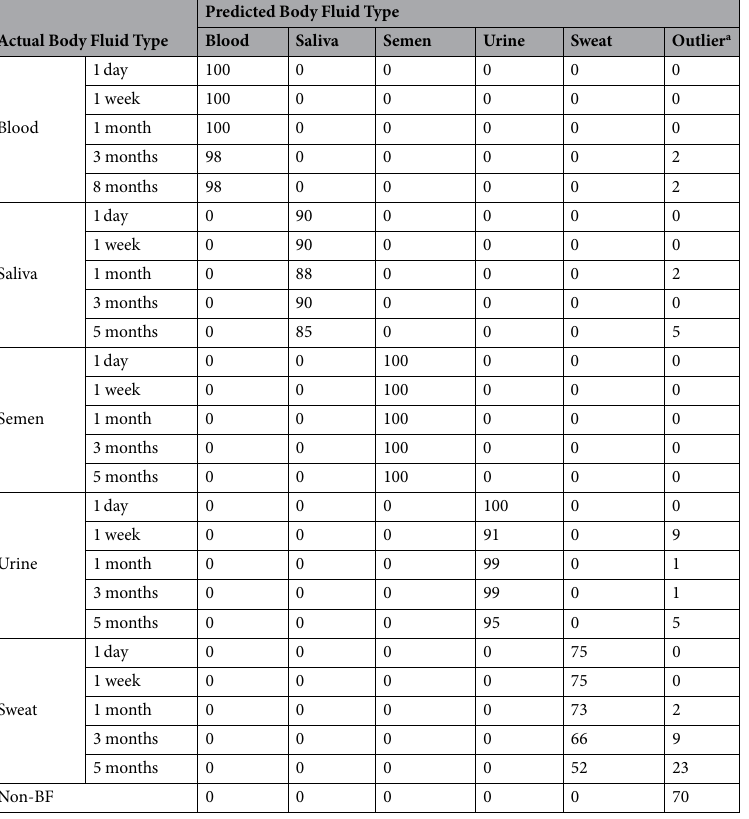
Table 2. Discrimination results for the ATR FT-IR spectra of aged BFs (1 day to 8 months) and unexpected samples using the dichotomous classification tree followed by Q-tests for each BF group. a Q-tests for each BF group were implemented with a statistical significance level of